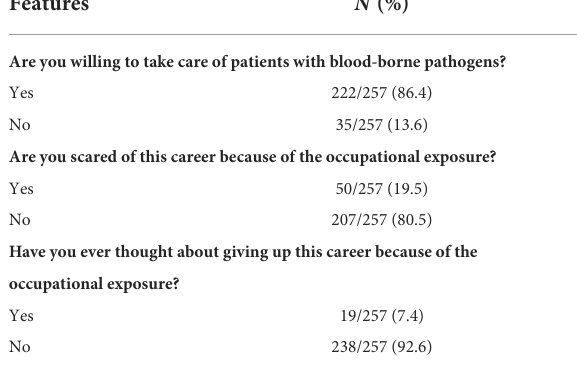
TABLE 3 Occupational expectation ( n =